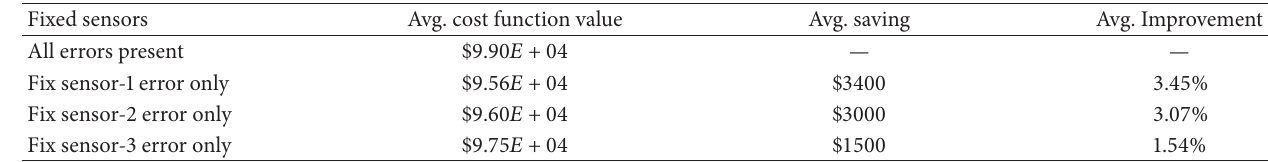
Table 2: Error elimination of sensors with the approximation methodology (KPI-1).